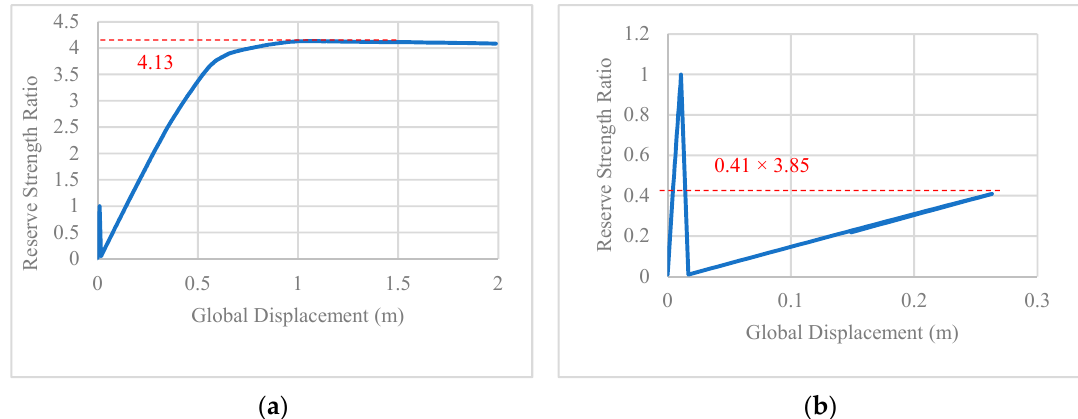
Figure 9. Global load versus global displacement for PP8-88: ( a ) PP8-88: without wave-in-deck load; ( b ) PP8-88: with wave-in-deck load.